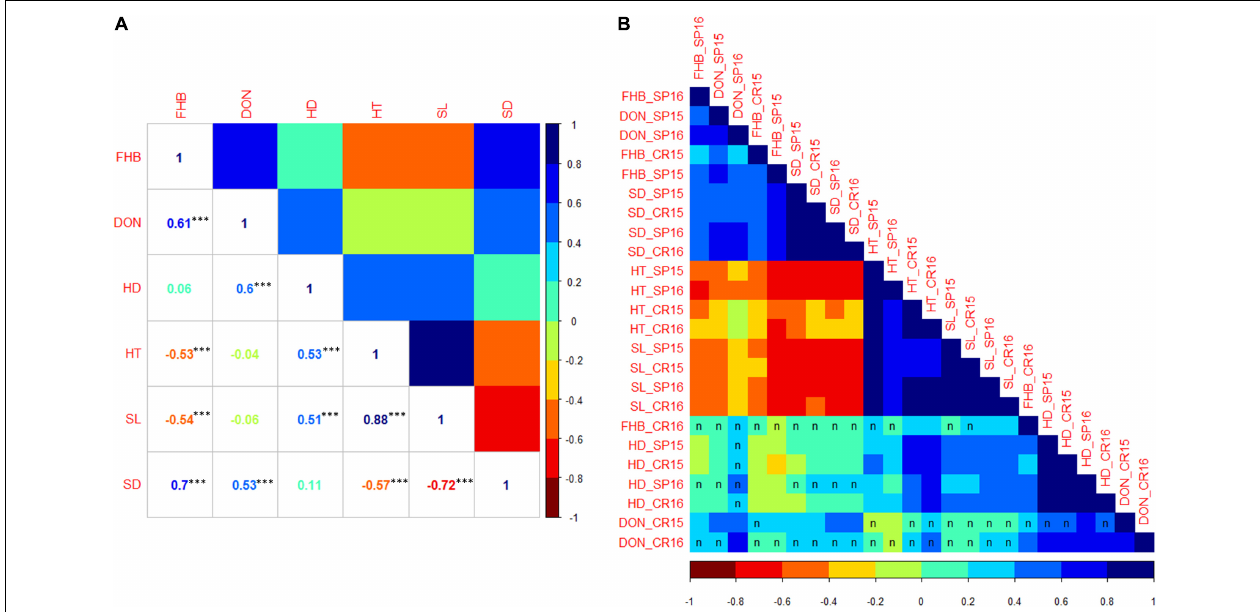
FIGURE 3 | (A) Correlation coefficients among traits based on BLUP values across all four environments. ∗∗∗ Significant at p < 0.001. (B) Heat map of the correlation matrix among traits based on mean values of each RIL within individual environment. Matrix was ordered by hierarchical clustering. Correlation between environments was significant at p < 0.05 level unless indicated by letter ‘n.’ FHB, Fusarium head blight; DON, deoxynivalenol accumulation; HD, heading date; HT, plant height; SL, spike length; SD, spike density.